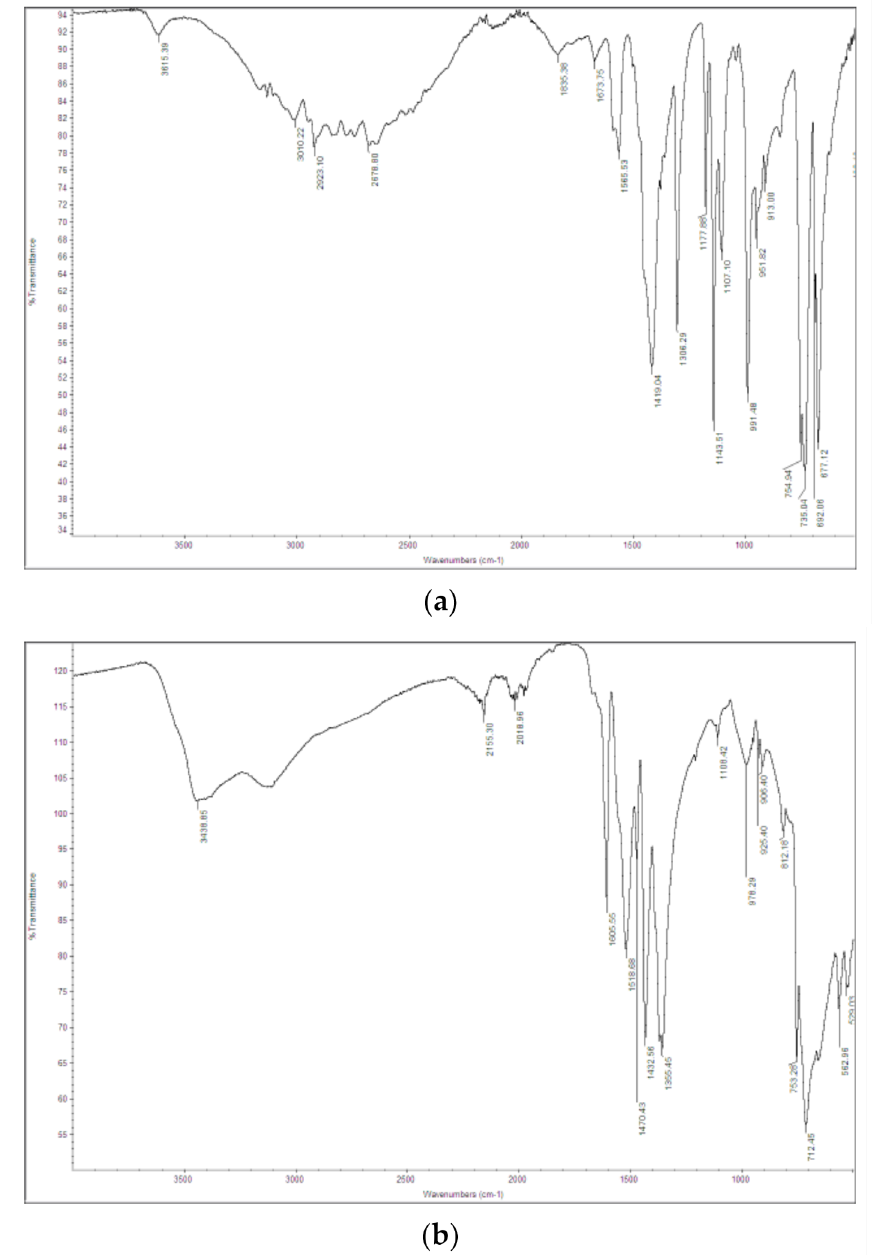
Figure 2. Fourier-Transform Infrared (FT-IR) spectra of ( a ) ZIF-8 and ( b ) Zn 3 (BTC) 2